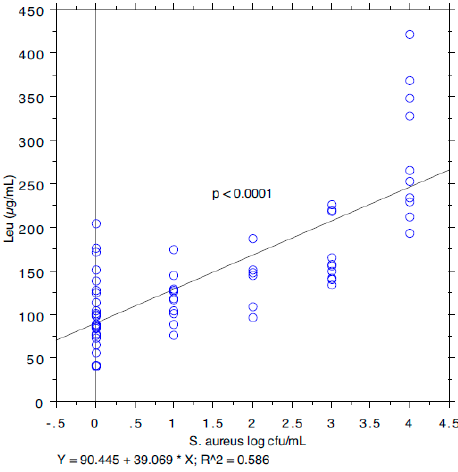
Figure 3. Pearson correlation between leucine content and S . aureus load.